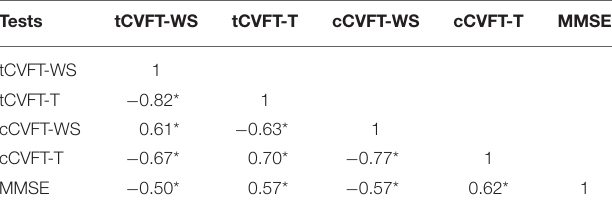
TABLE 2 | Correlations between the semi-automatically administered categorical verbal fluency test, conventionally administered categorical verbal fluency test, and Mini-Mental State Examination.